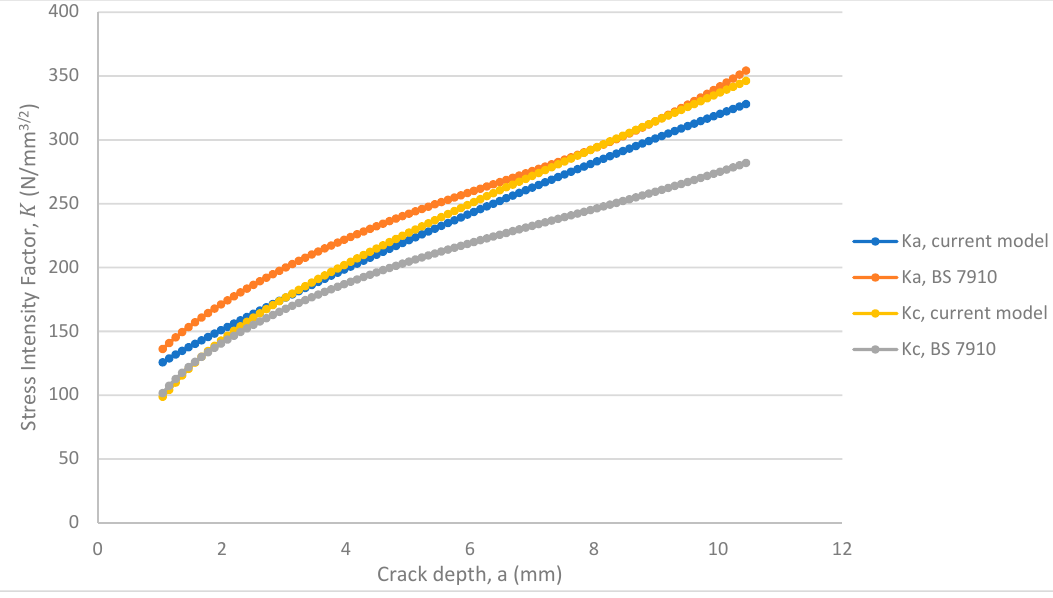
Figure 26. SIFs at the deepest point ( K a ) and surface point ( K c ) for an internal semi-elliptical crack in a pipe under cyclic tension (initial a / c = 0.5).